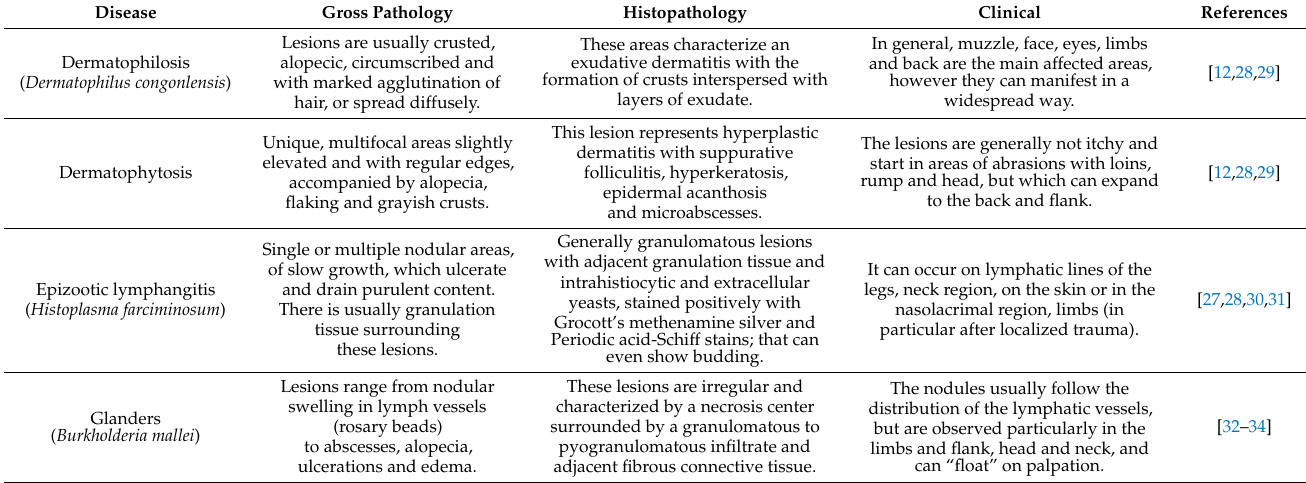
Table 1. Clinical and pathological characteristics of skin diseases caused by fungi and bacteria in donkeys and mules. Disease